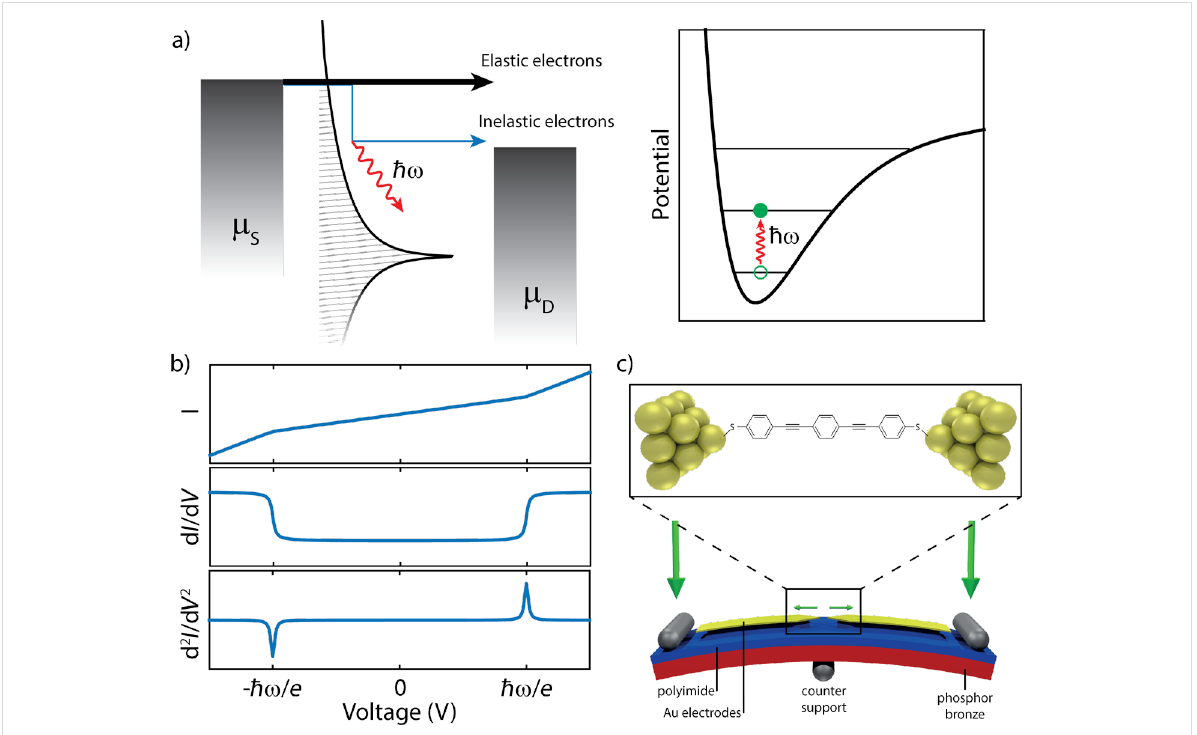
Figure 1: (a) Schematic of the inelastic electron tunneling spectroscopy (IETS) in a single-molecule junction. Charge transport happens through the tail of the Lorentzian broadened occupied molecular level depicted. The wiggly red line represents a molecular vibration excited after an inelastic scat- tering event (shown also in the right panel). (b) IETS shows up as a kink in the IV (upper panel), a step in the d I /d V (middle panel), and a peak in d 2 I /d V 2 (lower panel). (c) Schematic illustration of the MCBJ technique. The large green arrow indicate the force to bend the sample. The small arrows illustrate the attenuated electrode displacement. The inset shows an idealized illustration of a single-molecule junction, with OPE3 trapped between the